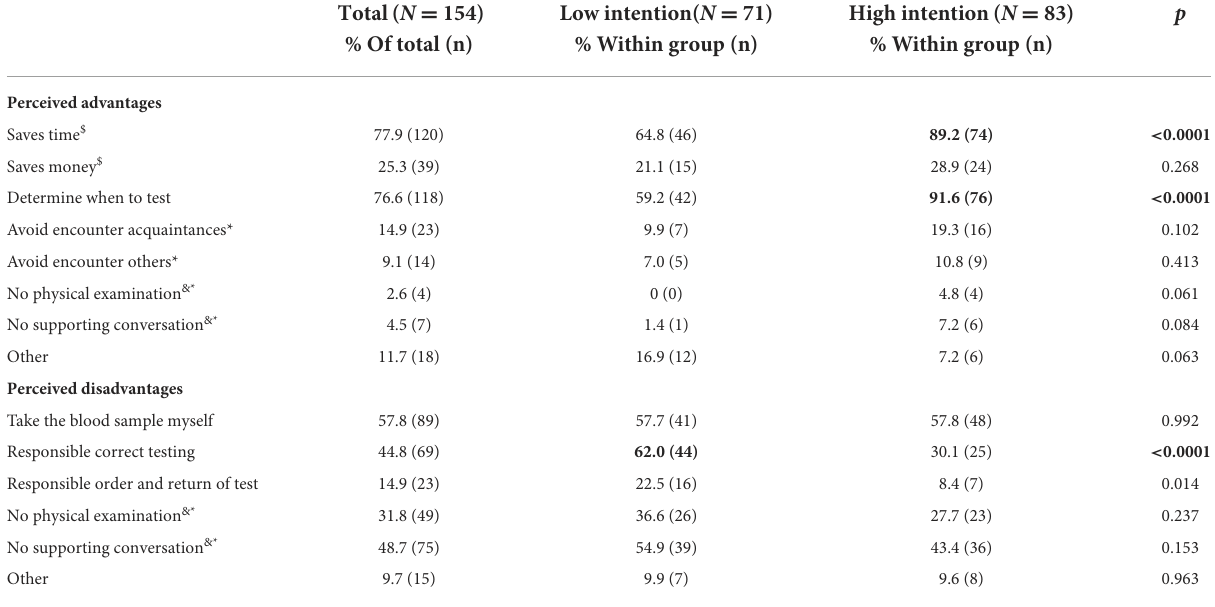
TABLE 3 Perceived advantages and disadvantages of self-sampling testing compared between low or high intention to use self-sampling testing.